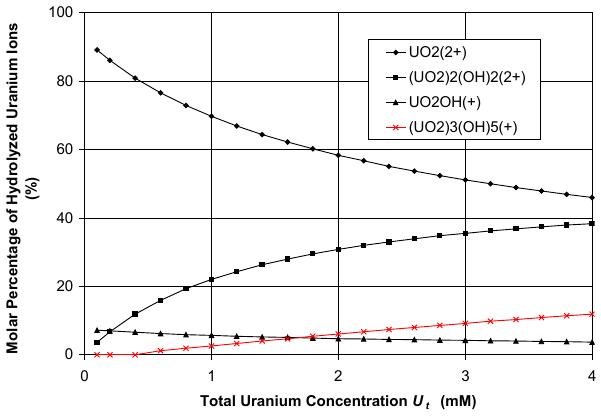
) (OH) 22+ ; (3, 5): (UO2) 2 2